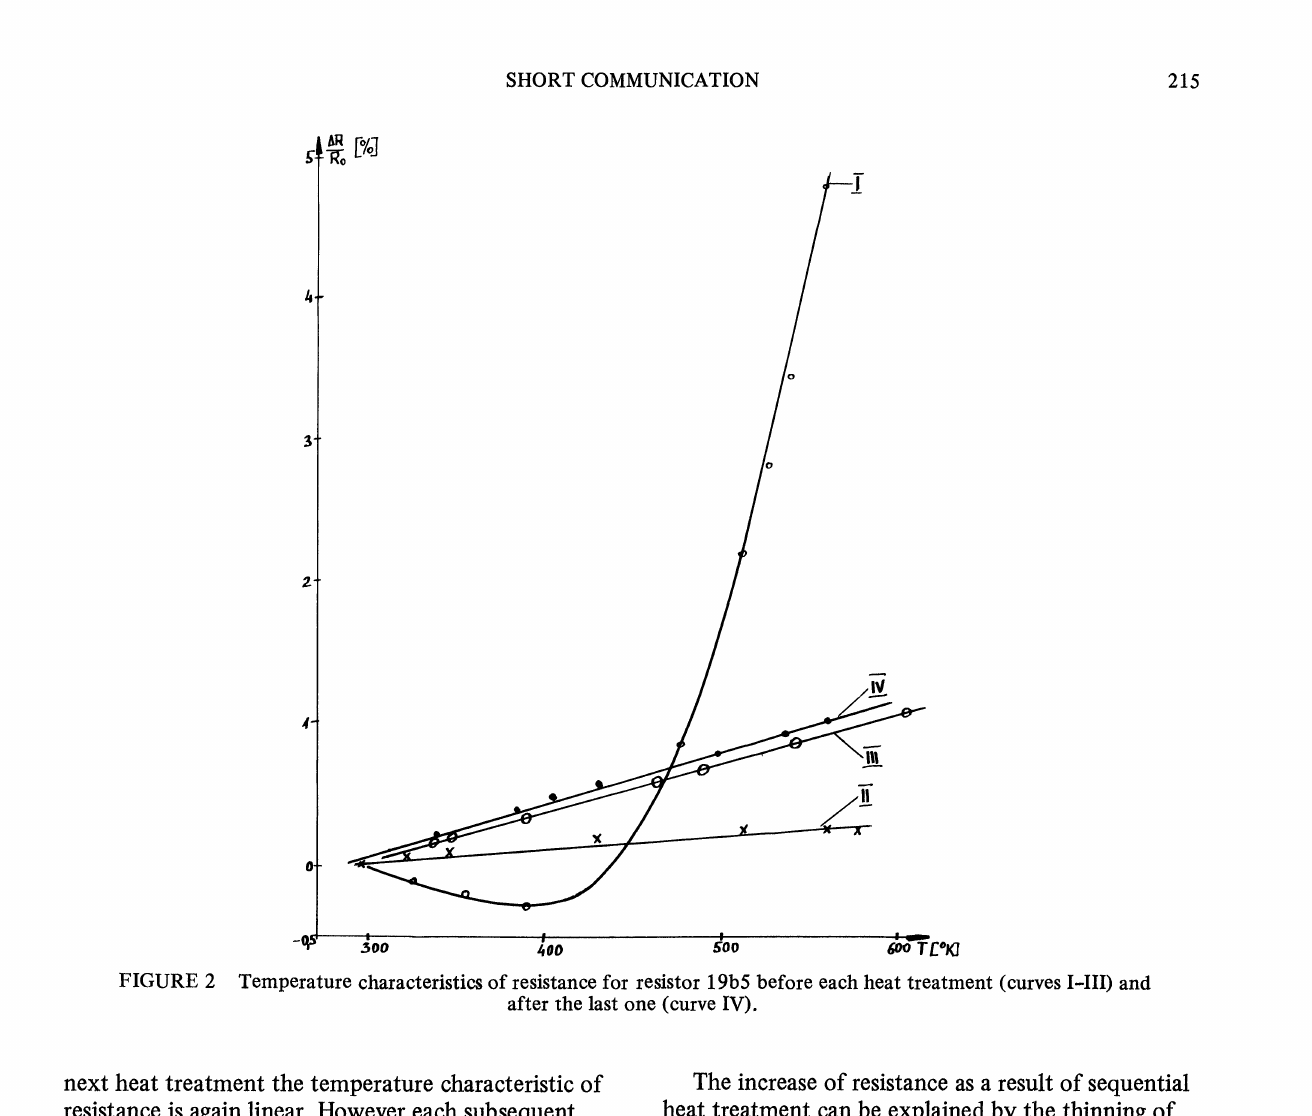
FIGURE 2 Temperature characteristics of resistance for resistor 19b5 before each heat treatment (curves I-III) and after the last one (curve IV). next heat treatment the temperature characteristic of resistance is again linear. However each subsequent heat treatment results in an increase of